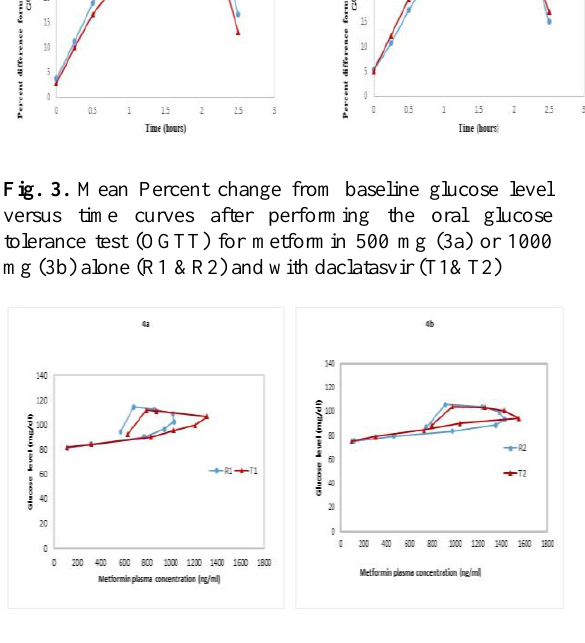
Fig. 4. Relationship between Metformin plasma concentration and pharmacodynamic response after oral glucose tolerance test for metformin 500 mg (4a) or 1000 mg (4b) alone and with daclatasvir showing counterclockwise